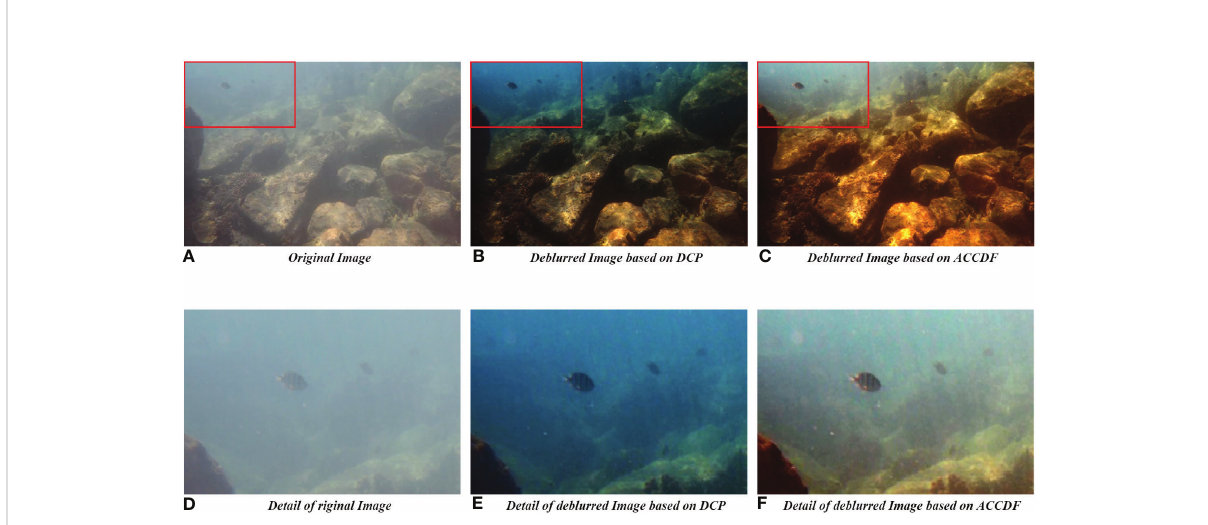
FIGURE 3 (A – C) Images are comparison of the deblurred image based on dark channel prior (DCP) and adaptive correction of channel differential and fusion (ACCDF), respectively. (D – F) are the details of (A – C)